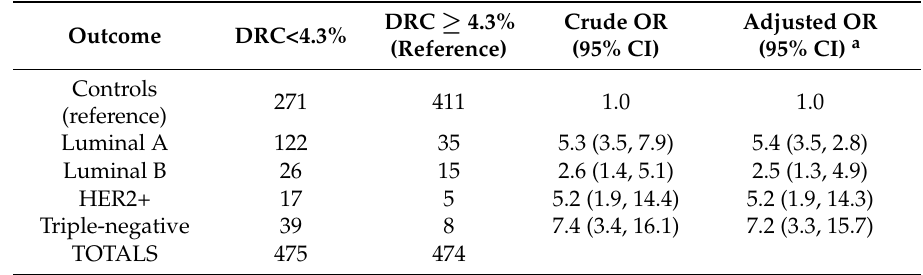
Table 3. Multinomial odds ratio regression analysis for association between DNA repair capacity and breast cancer